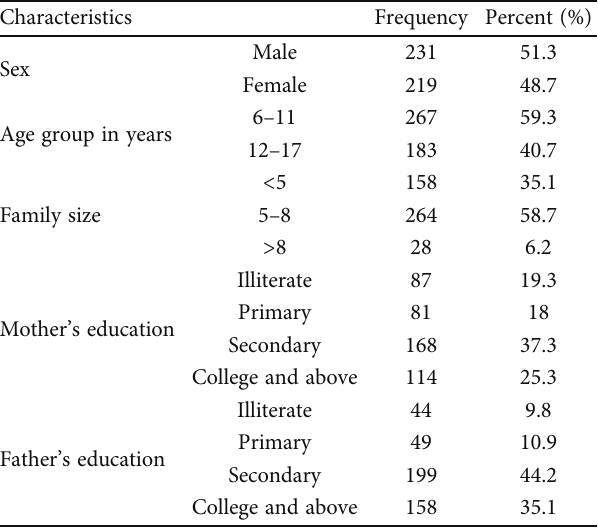
Table 1: Sociodemographic characteristics of primary school children in Dessie town, North-central Ethiopia,